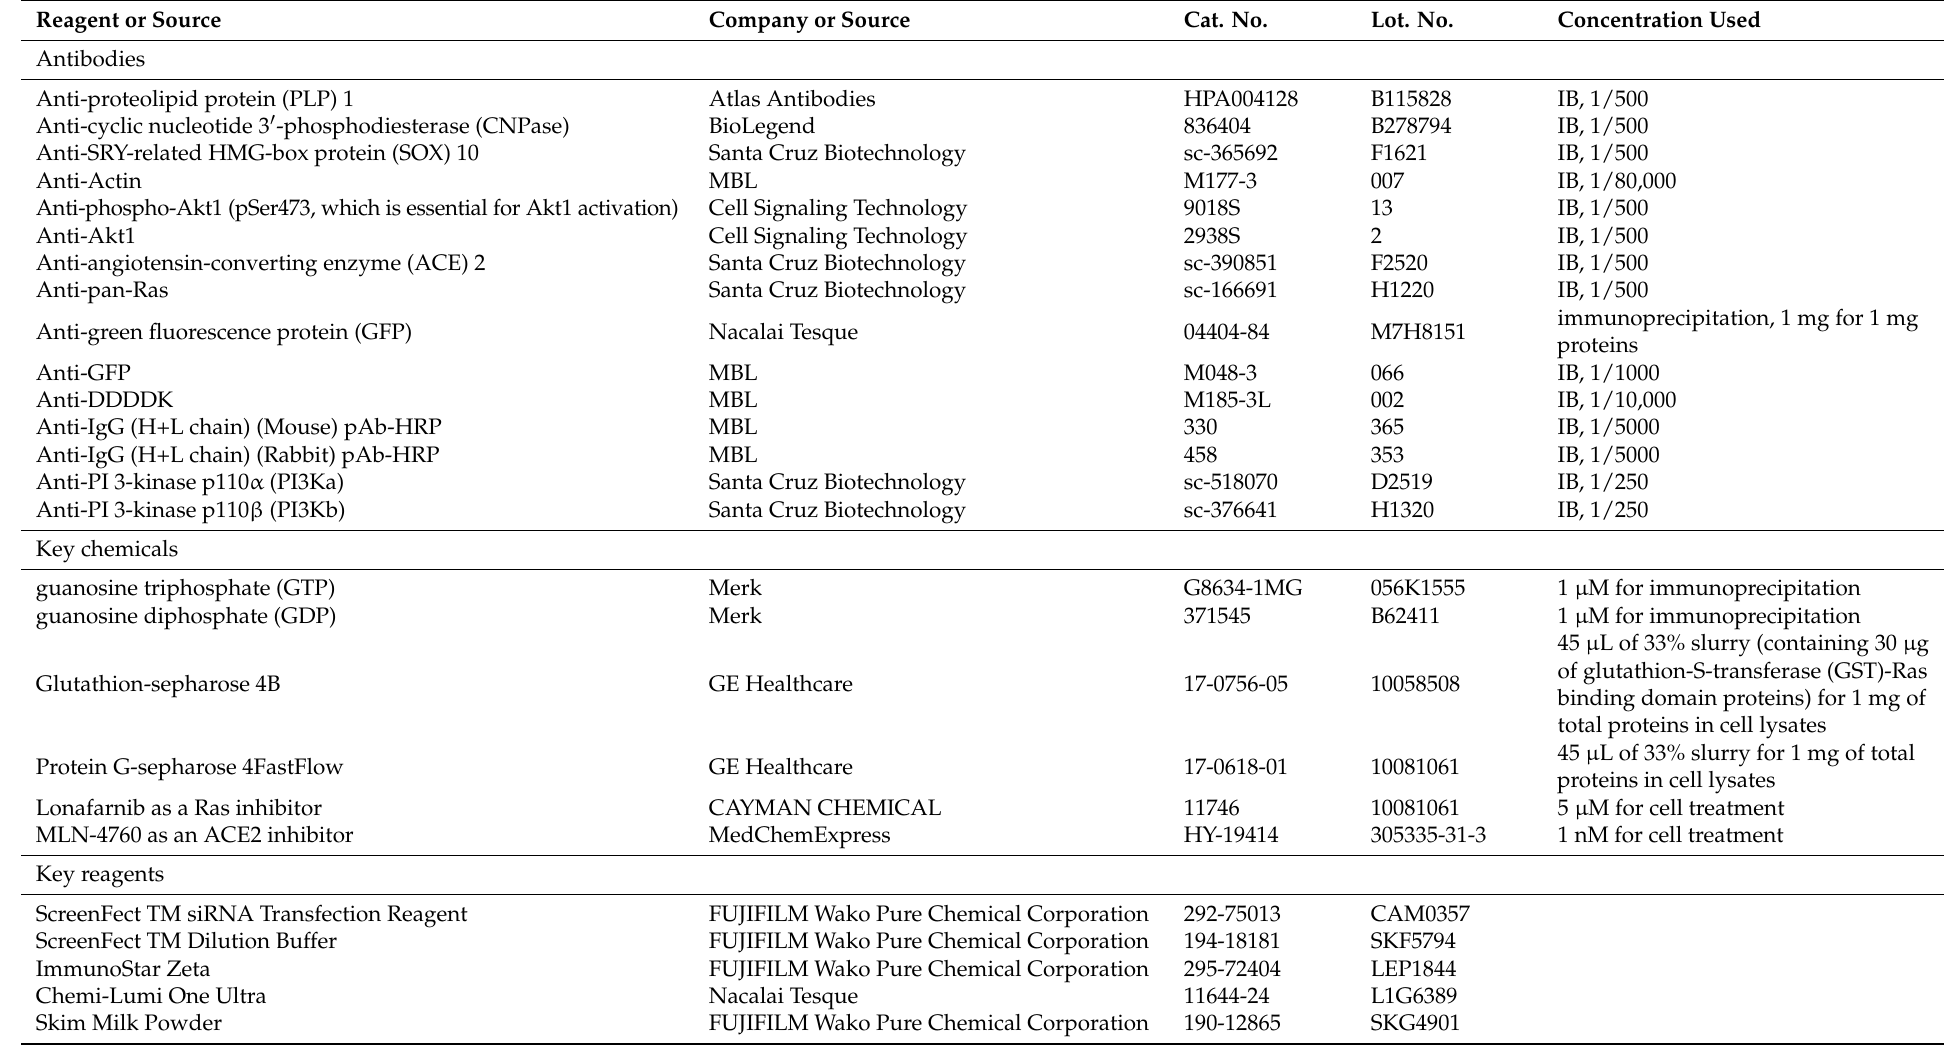
Table 1. Key antibodies and chemical sources. All key materials such as antibodies are